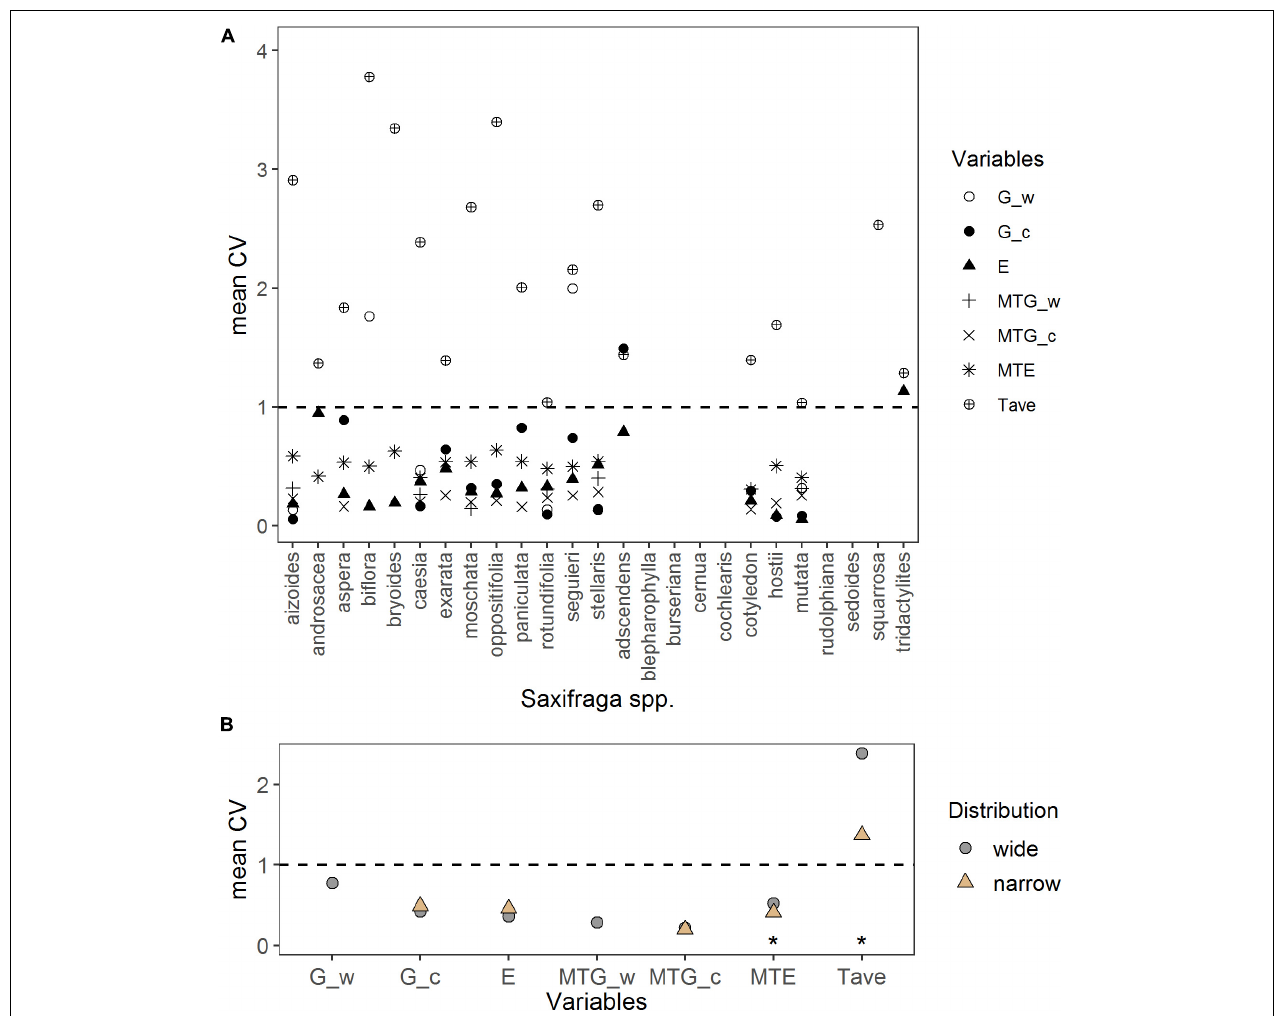
FIGURE 6 | (A) Intraspecific variation per species represented by the coefficient of variation (CV) of response variables: Germination percentage in warm (G_w) and cold (G_c) temperature in the laboratory, emergence percentage (E), mean time to germination in warm (MTG_w) and cold (MTG_c) temperature, mean time to emergence (MTE), and average annual temperature at the seed collection sites (Tave). (B) Comparison of mean CV of response variables per distribution range, done by linear regressions. Note different maxima on y -axis between panels. Stars denote significances at α = 0.05